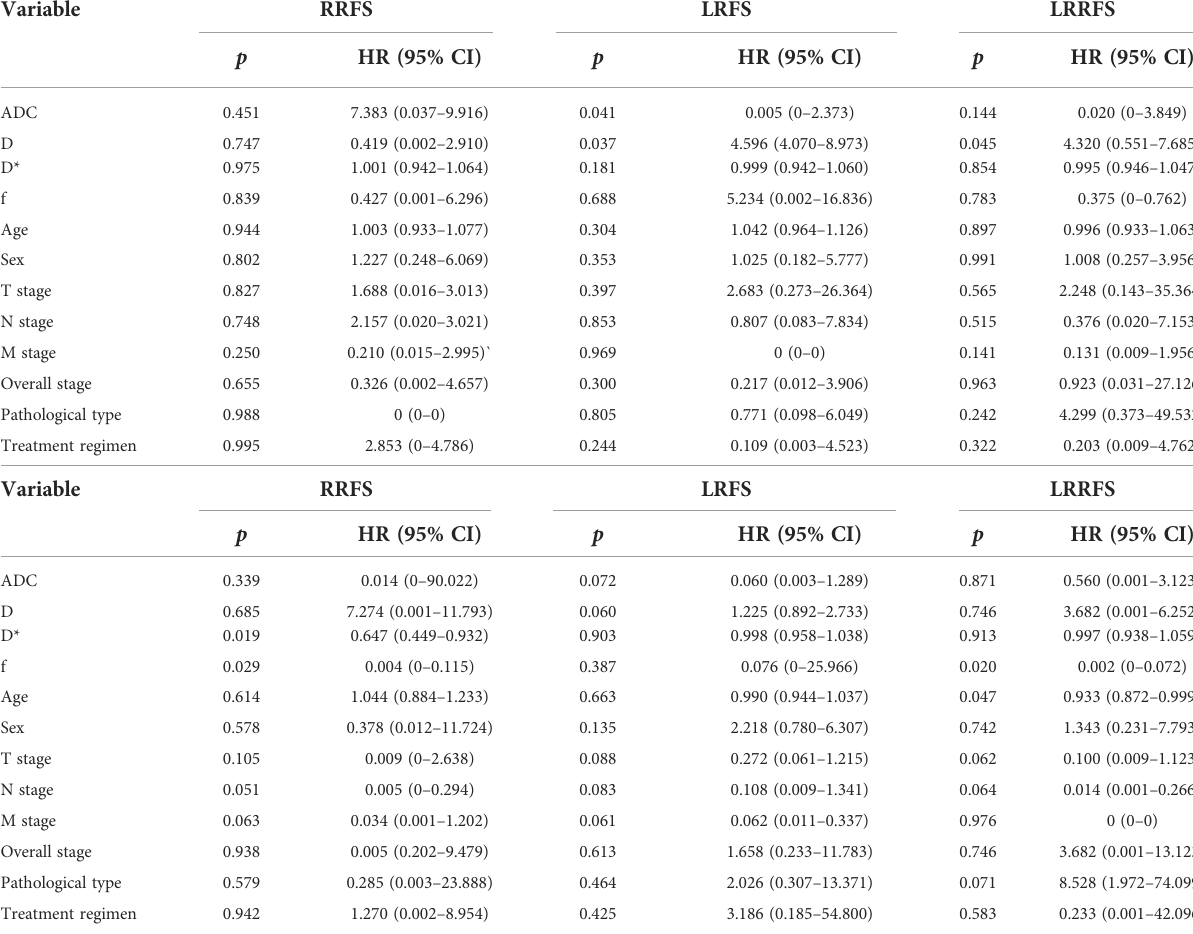
TABLE 4 Multivariate analyses of the prognostic factors in the 97 nasopharyngeal carcinoma patients.